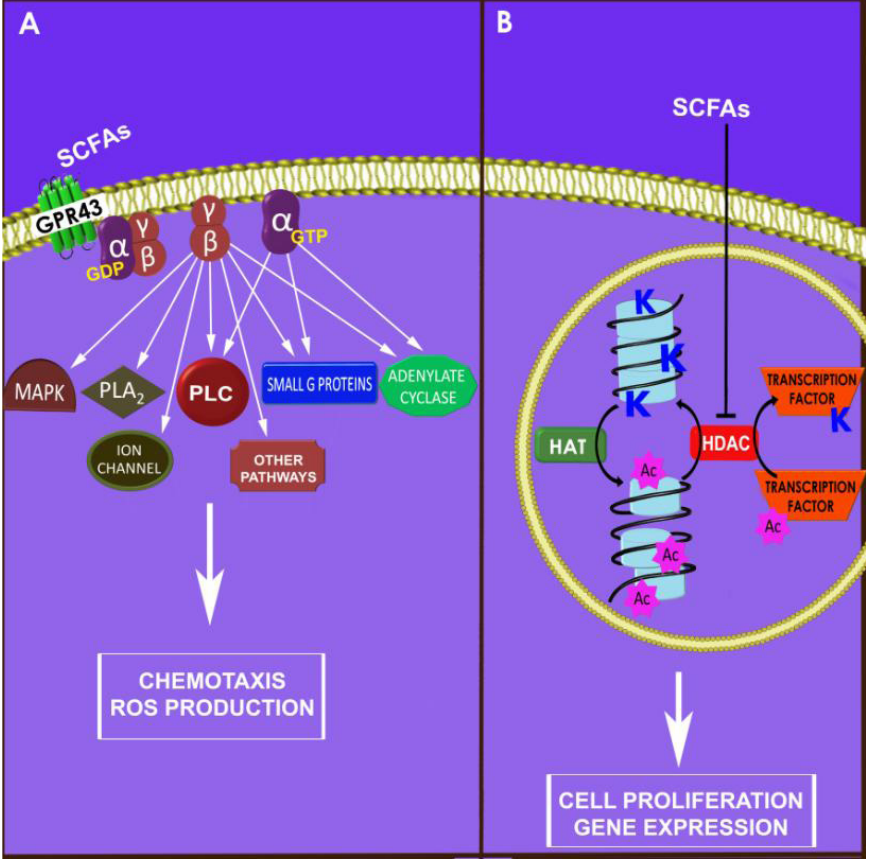
Figure 2. Schematic overview of the signaling pathways activated downstream of GPR43 receptors and representation of the effects of SCFAs through inhibition of histone deacetylase (HDAC) activity ( B ). GPR43 couples to Gi and Gq proteins, which interact with several proteins including adenylate cyclase, small G proteins (e.g., Rac and Rho), mitogen-activated protein kinases (MAPK), phospholipase C (PLC) and A channels and transcription factors ( A ). SCFAs may also act on cells through inhibition of HDAC ( B ). This class of enzymes, together with histone acetyltransferase (HAT), controls the acetylation state of histones and non-histone proteins and, consequently, modulates the transcription of several